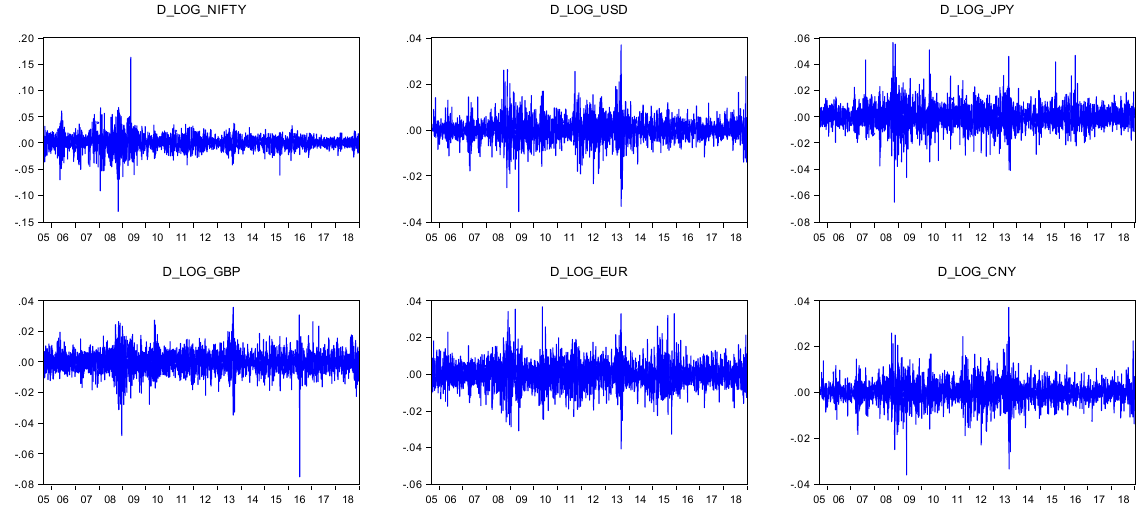
Figure 2. Variables after first log difference.